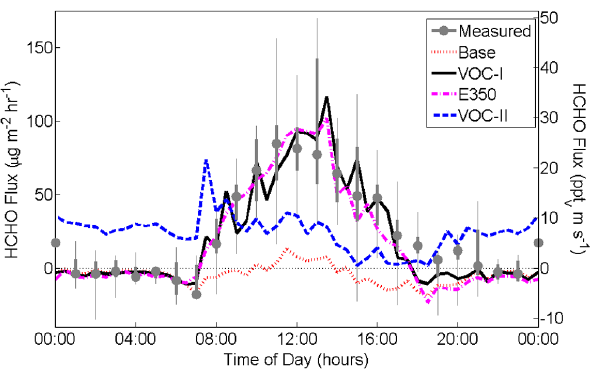
Fig. 6. Comparison of model results with measured HCHO fluxes. Grey dots denote the 1h binned median of measured flux, while thick gray lines denote the interquartile range of measured flux for each bin, and thin gray lines denote the entire range. Base refers to the unaltered model result. VOC-I and VOC-II refer to the base model with tenfold simulated increases in MBO and MT respec- tively. E350 refers to the base model with a direct HCHO emission rate from PPine of 350ng ( g dw ) − 1